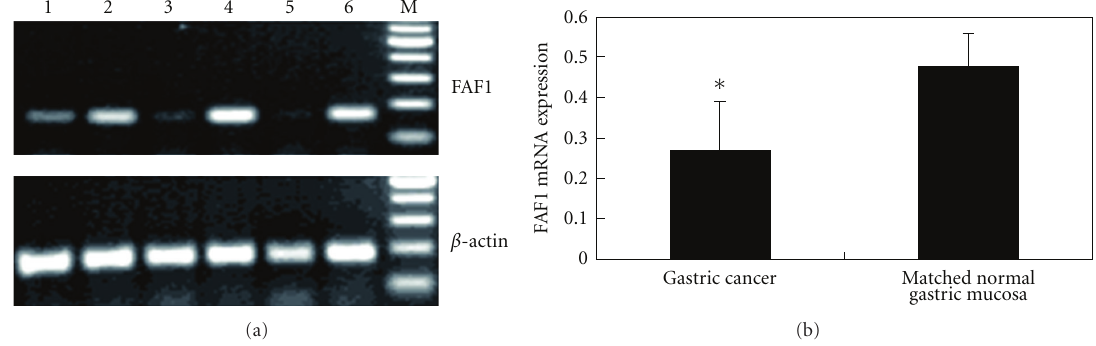
Figure 1: RT-PCR analysis of FAF1 mRNA expression in gastric cancer tissue and matched normal gastric mucosa tissue. (a) RT-PCR to measure levels of FAF1 and β -actin mRNA. Lanes 1, 3, 5: gastric cancer tissue from di ff erent patients. Lanes 2, 4, 6: corresponding normal gastric mucosa tissue from the same patients. M, 100-bp DNA marker ladder. β -actin was used as an internal control. (b) Comparison of FAF1 mRNA levels (normalized to β -actin levels) in gastric cancer tissue and matched normal gastric mucosa tissue. FAF1 mRNA levels were much lower in the gastric cancer tissue samples based on the mean ± SD test. ∗ P < 0 . 05.